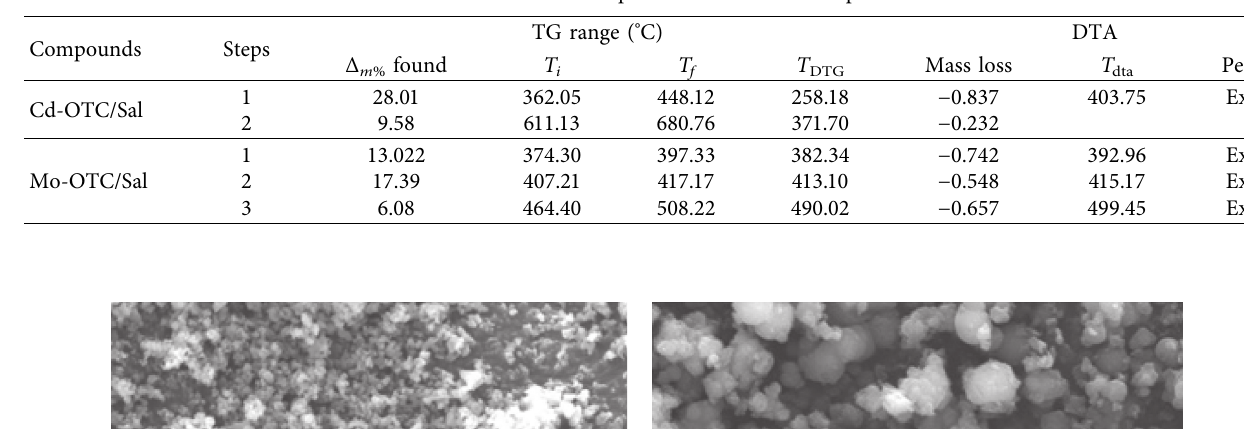
Table 2: Thermal decomposition data of the complexes.